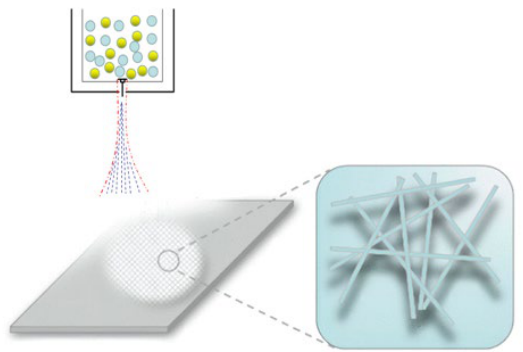
Figure 1. Schematic diagram of melt-blowing web formation.